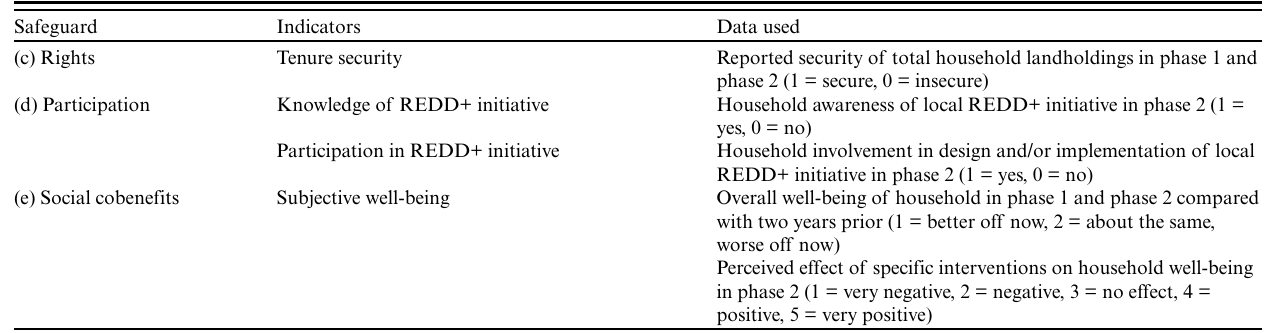
Table 1 . Household-level data used to operationalize REDD+ social safeguards (c)-(e).